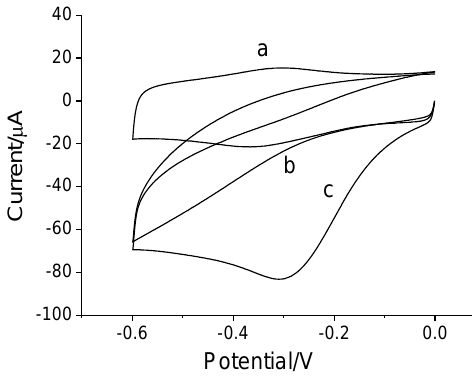
Figure 8. Cyclic voltammograms of the Hb/FDU-15 electrode in 0.1 M PBS (pH 7.0) (curve a); the FDU-15 electrode (b) and the Hb/FDU-15 electrode (c) in the presence of 0.5 mM H O . Scan rate: 100 mV s −1 2 2